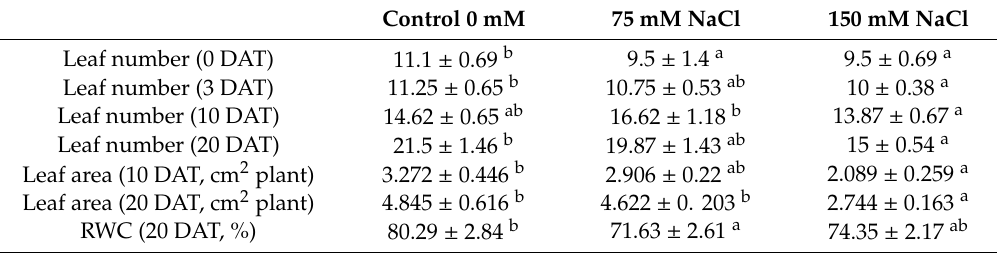
Table 1. The influence of salt treatments (0, 75, and 150 mM NaCl) on leaf area and leaf number per plant determined during the growth of Lawsonia inermis . Relative water content (RWC, %) was determined at the end of treatment. Values are means ± Standard Error (SE) ( n = 9). Di ff erent letters indicate statistically significant di ff erences with Fisher’s probable least-squares di ff erence test ( p ≤